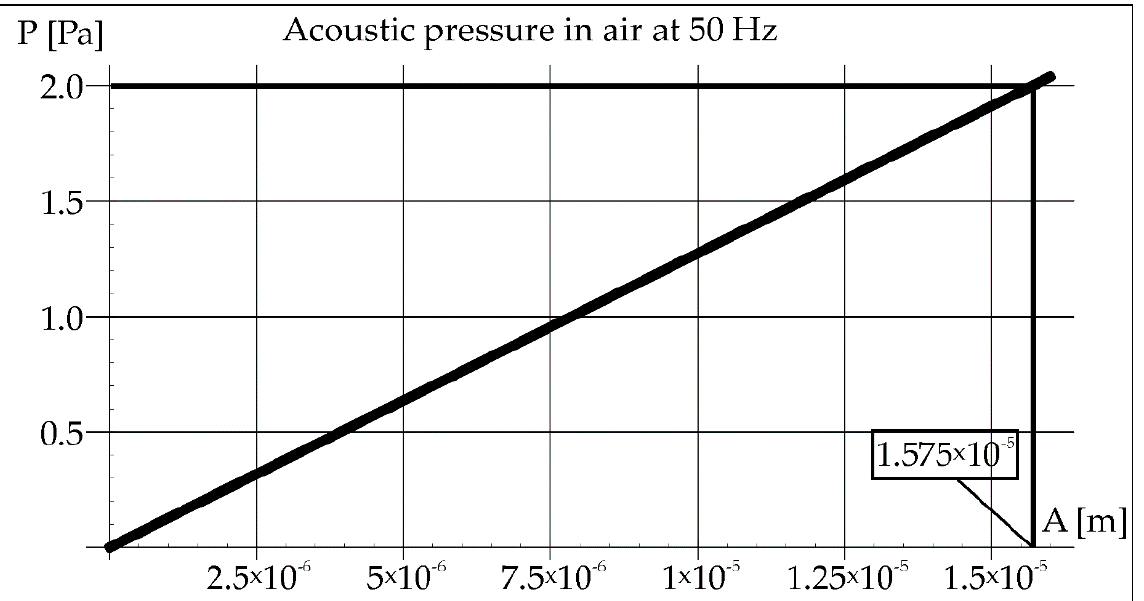
Figure 2. Acoustic pressure in air at frequency 50 Hz.